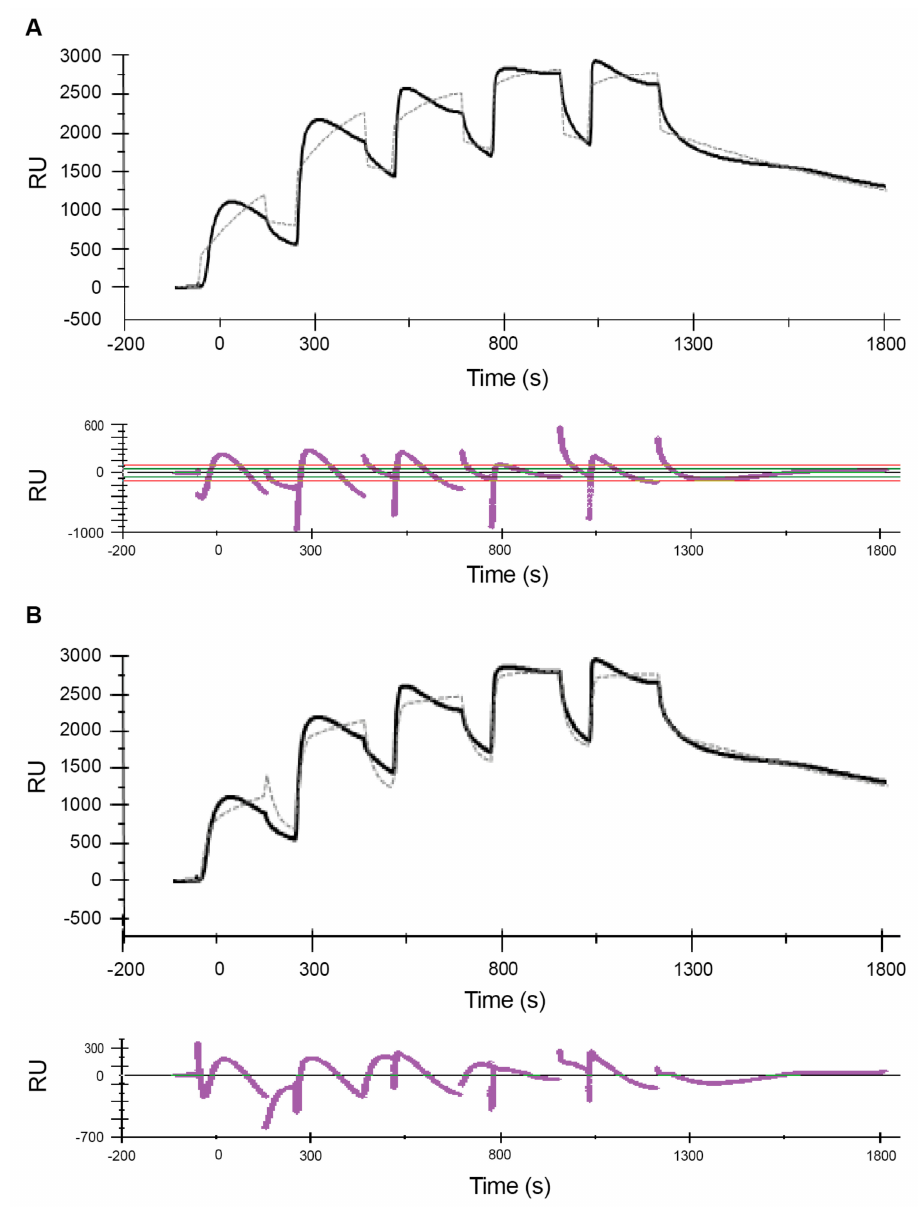
Figure 5. E ff ect of sodium chloride on melittin–POPC interaction—single-cycle kinetics. Following immobilization of POPC liposomes (1 mM lipid), increasing concentrations of melittin (0.5, 1, 2, 4 and 8 µ M), made up in running bu ff er containing 0.15 M NaCl, were serially injected, following a single-cycle kinetic approach. The sensorgrams were fitted to a 1:1 Langmuir model ( A ) and two-state reaction model ( B ) using BIAevaluation ® software. The estimated rate constants and a ffi nity values, based on both these models, are listed in Tables 1 and